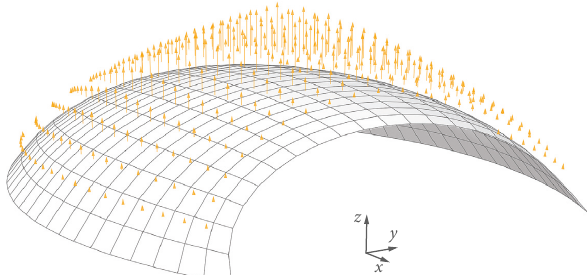
Figure 15: Illustration of the additional form adaption, fading two dimensionally from the shell vertex.